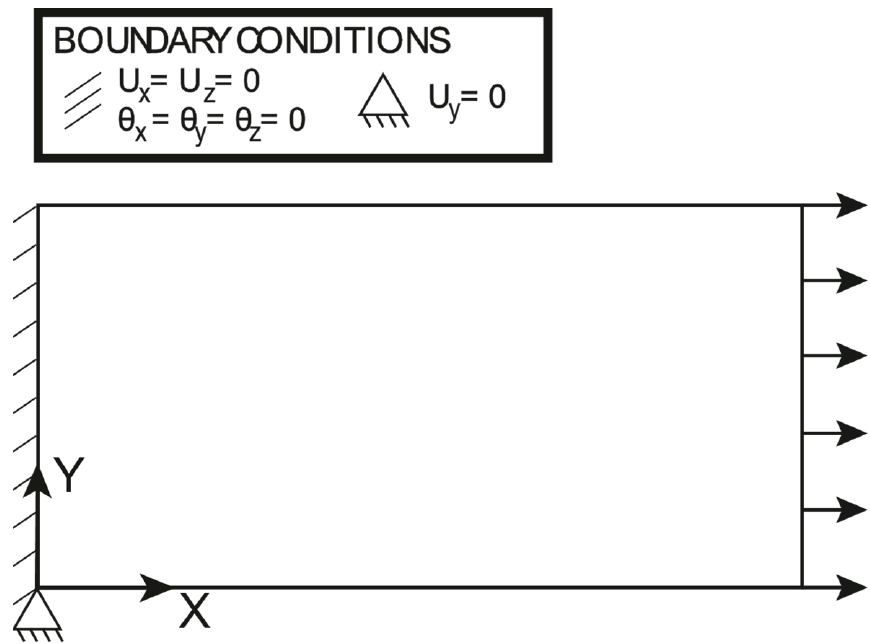
Figure 5 . Traction: loading and boundary conditions. Figure 5. Traction: loading and boundary conditions. Table 2 . Traction: selected polynomial pre-extrapolation orders. Table 2. Traction: selected polynomial pre-extrapolation